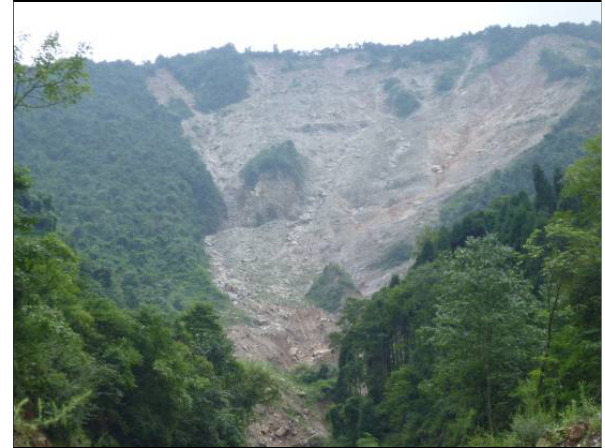
Fig. 8. Loose deposits in the upper part of the No. 5 branch of the Zoumaling gully.